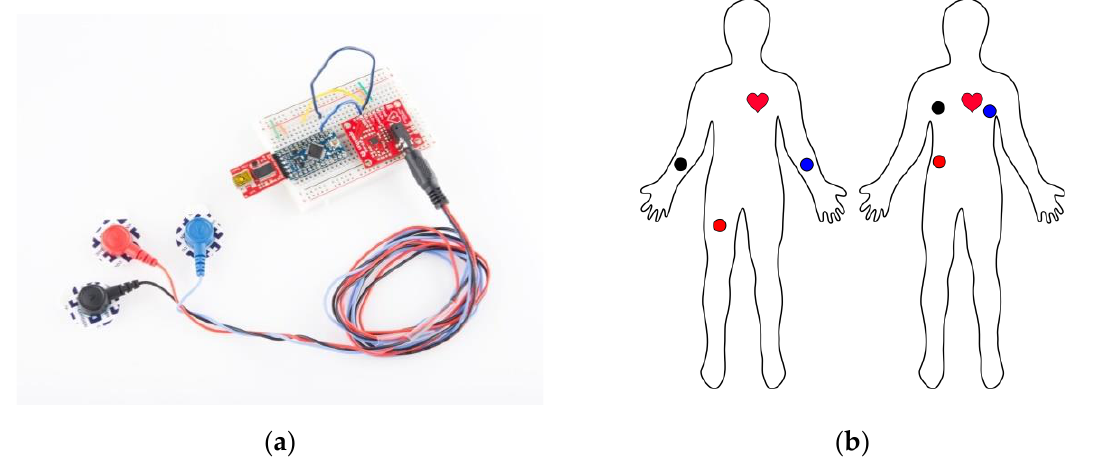
Figure 1. ( a ) Connection of ECG electrodes to the AD8232, which is connected to an Arduino board on the other side; ( b ) typical electrode positions. From [39], originally published under a CC-BY-SA 4.0